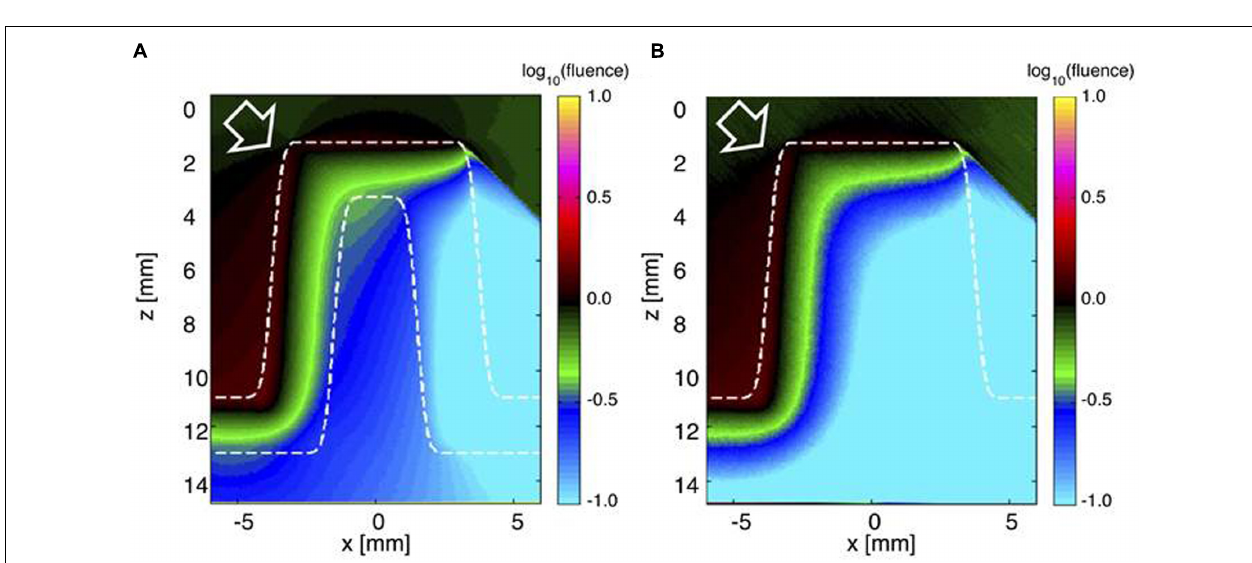
FIGURE 4 | Monte Carlo simulation of light distribution in a faviid coral for vertically incident collimated illumination. (A) The 2D distribution of relative 636 nm fluence rate φ ( z , x ) in the model coral (as in Figure 1A ). (B) The axial profile down the center of the coral coenosteum φ ( z ) at x = 0 mm. Note that the fluence rate within the living tissue is twice the delivered irradiance (1 cm − 2 ). Between z = 0 to 2 mm, the back-reflected light escaping from the tissue adds to the delivered irradiance to yield a fluence rate in water that exceeds 1 cm − 2 .